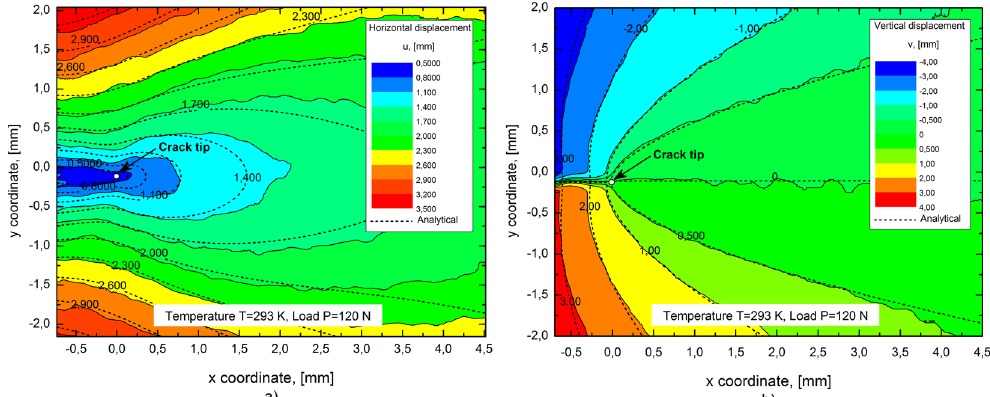
Figure 3. DIC displacement contours vs analytical solution (black dashed curves) for a SEC specimen ( a/W = 0.43) at P = 120 N and T = 293 K: ( a ) horizontal displacement u x and ( b ) vertical displacement u y